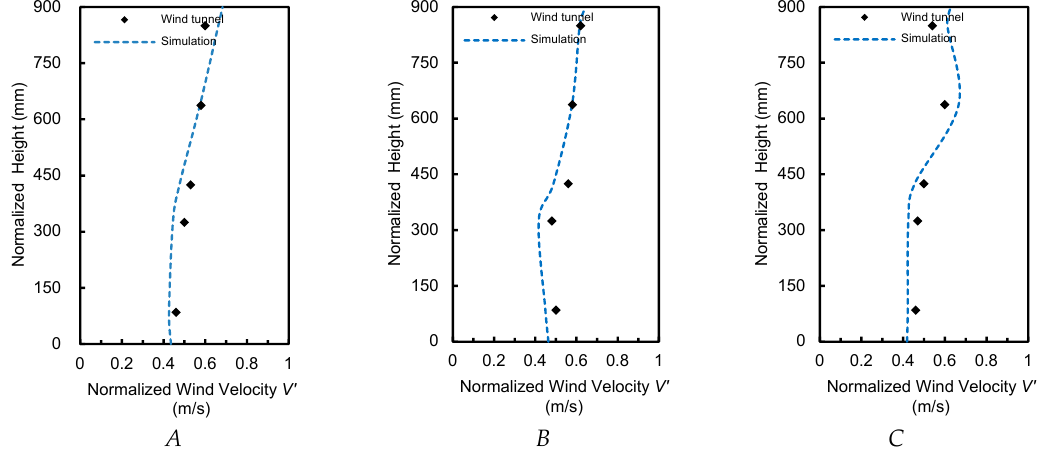
Figure 2. Comparison of normalized wind velocities in simulations and wind tunnel tests at points A , B and C . V’ = V x / V in , V x is the air speed at points A , B and C , respectively . V in is the inflow air speed.